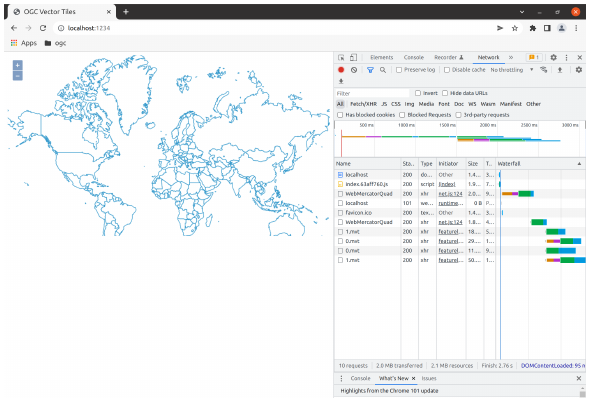
Figure 3. eMOTIONAL Cities SDI architecture